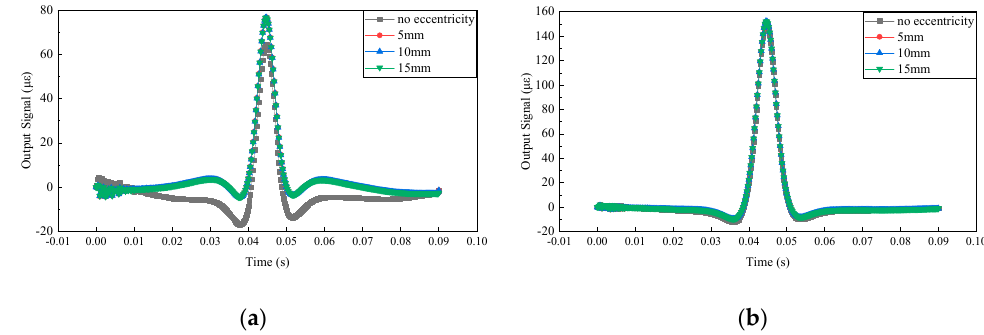
Figure 9. Comparison of influences of wheel eccentricity on different layout schemes: ( a ) Rail web bending moment method; ( b ) rail web compression method.